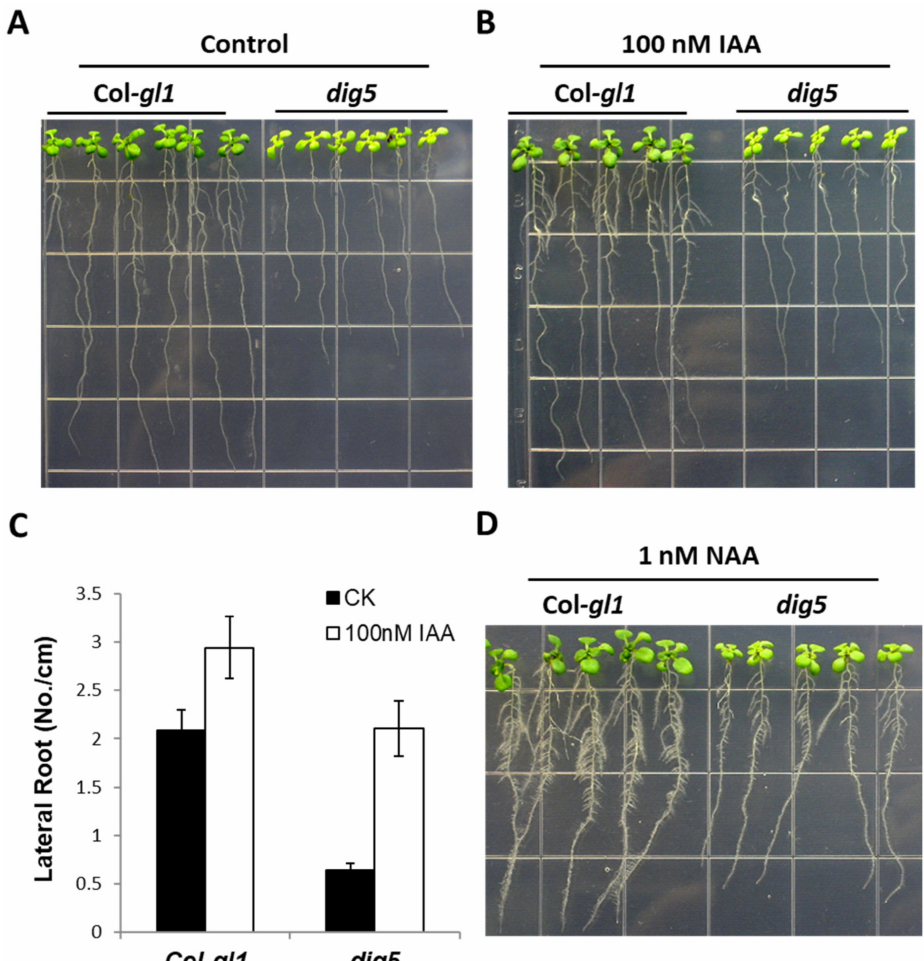
Figure 2. Lateral root phenotypes of dig5 mutant seedlings can be rescued by auxin. Lateral root growth of the wild type (Col- gl1 ) and dig5 without ( A ) or with ( B ) 100 nM IAA. ( C ) Lateral root density of seedlings shown in ( A , B ). Data are means and standard deviation ( n = 18). ( D ) Morphology of seedlings of the wild type (Col- gl1 ) and dig5 on 1 nM